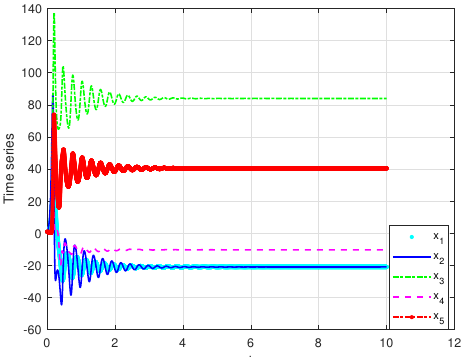
, r = 85, d = 19 and α = 0.95. 3 3